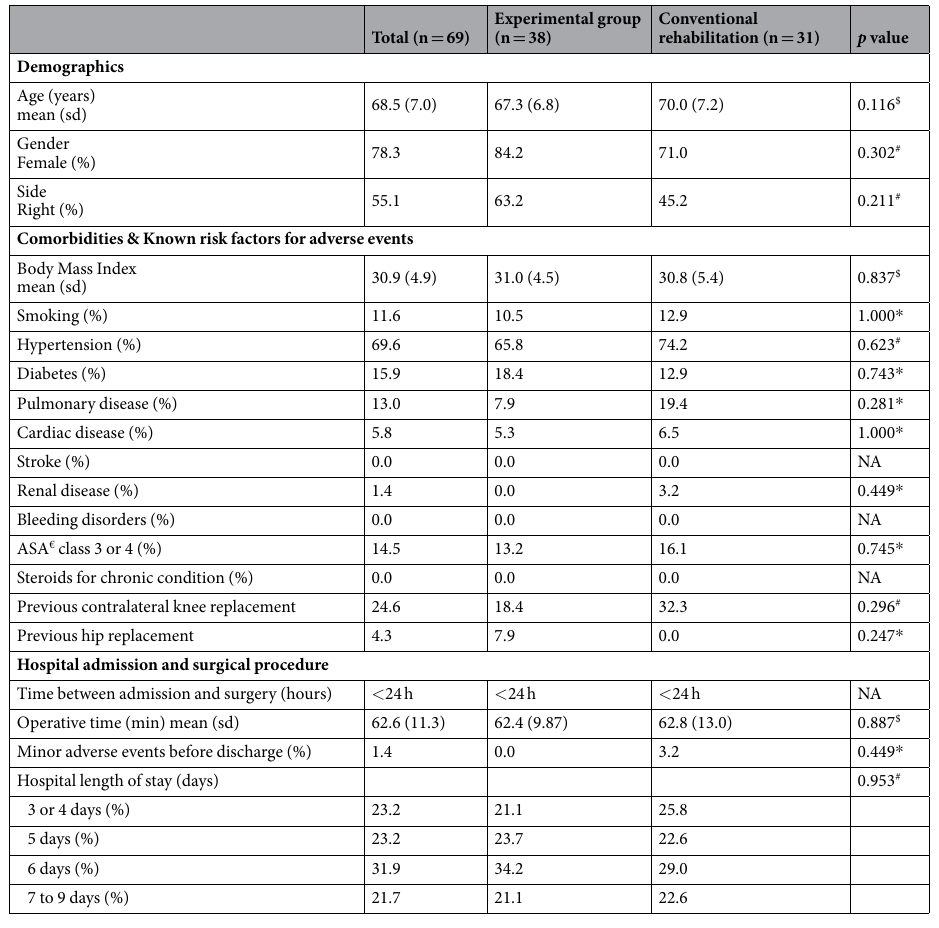
Table 1. Baseline characteristics of study participants. € American Society of Anesthesiology physical status classification system # Chi-Square test; * Fisher’s exact test; $ independent samples T